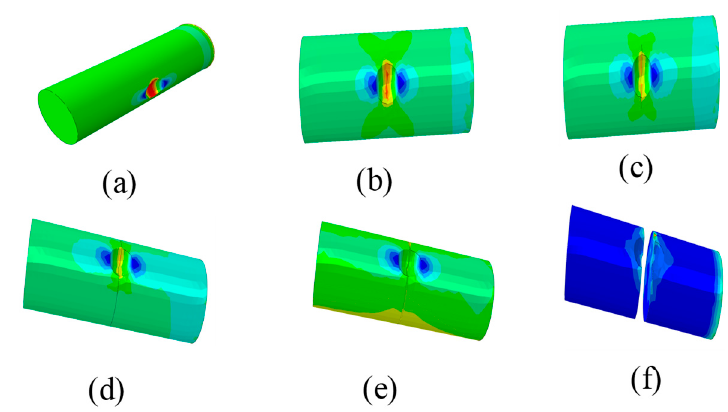
Figure 9. Crack growth process in Abaqus. ( a ) The stress concentration near the corrosion pit; ( b ) the crack initiation near the corrosion pit; ( c ) The crack growth near the corrosion pit ( d ) Crack growth-I; ( e ) Crack growth-II; ( f ) The corrosion fatigue fracture of high strength steel wire.